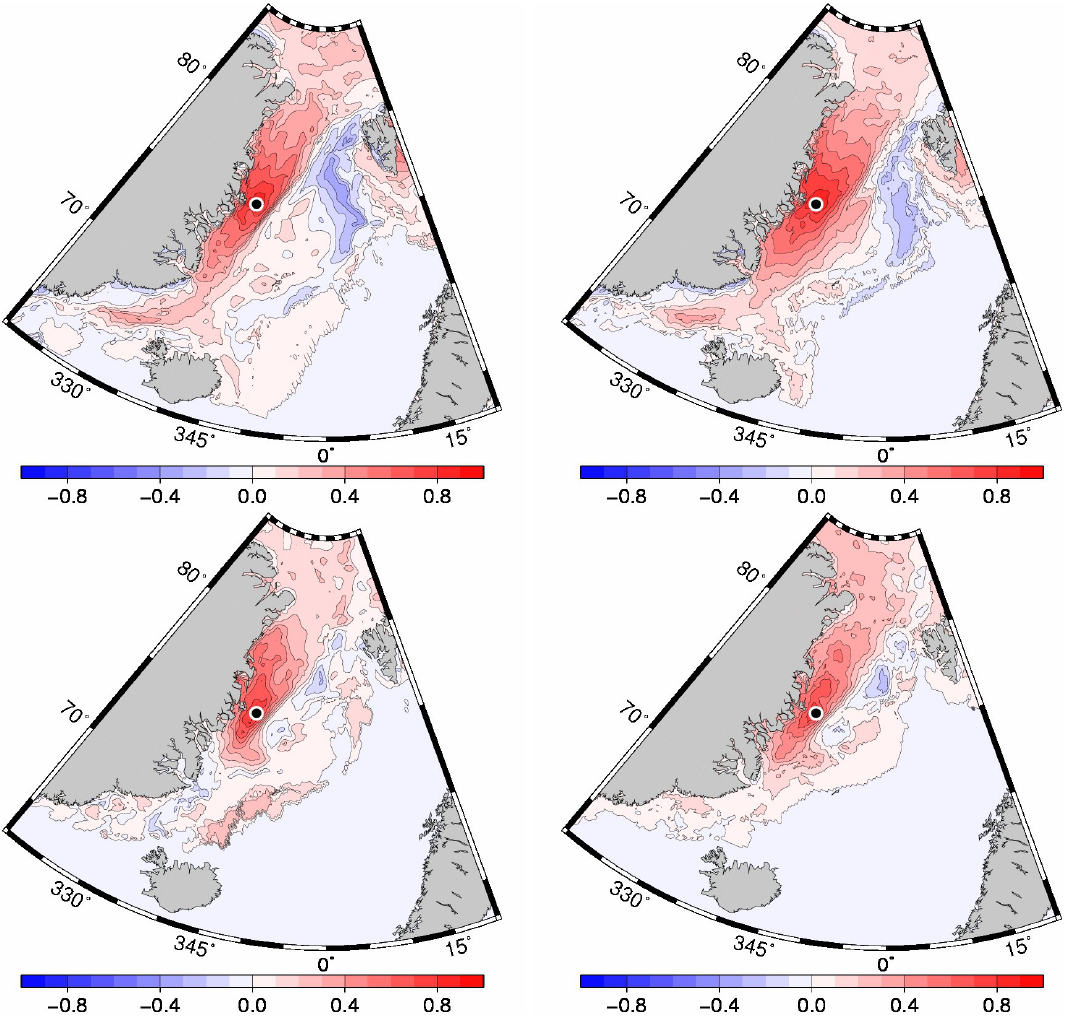
Fig. 12. Ice concentration horizontal correlation structure with respect to a reference location at 15 ◦ W 75 ◦ N (black dot) for 15 March (top panels) and 11 September (bottom panels), without anamorphosis (left panels), and after local anamorphosis transformations (right